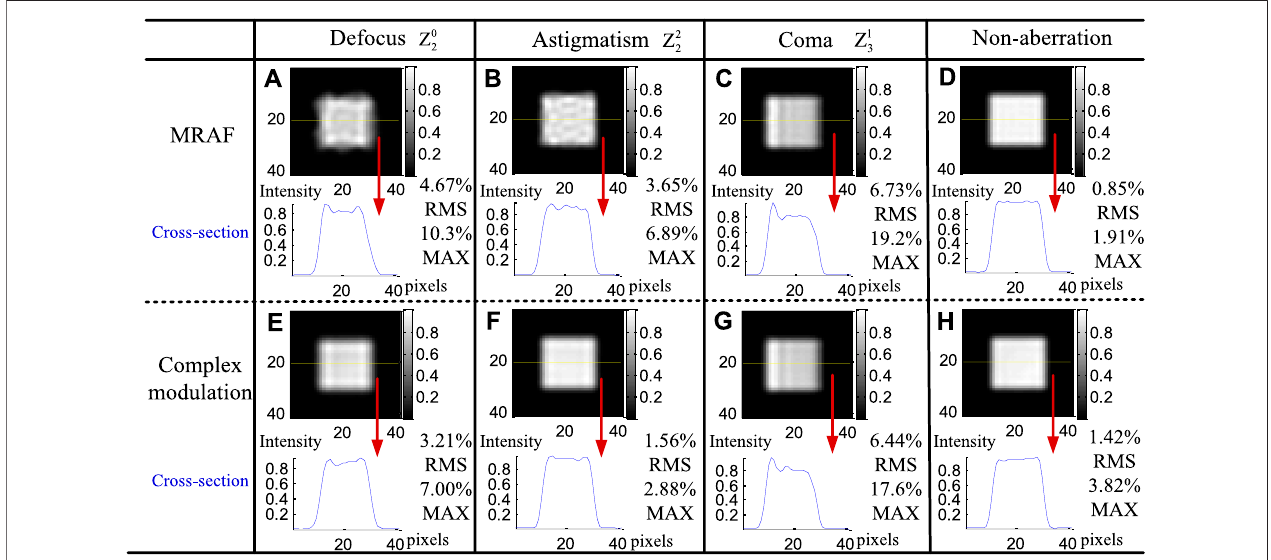
FIGURE 3 | Roughness analysis when the aberrations locate in the laser and expander system.